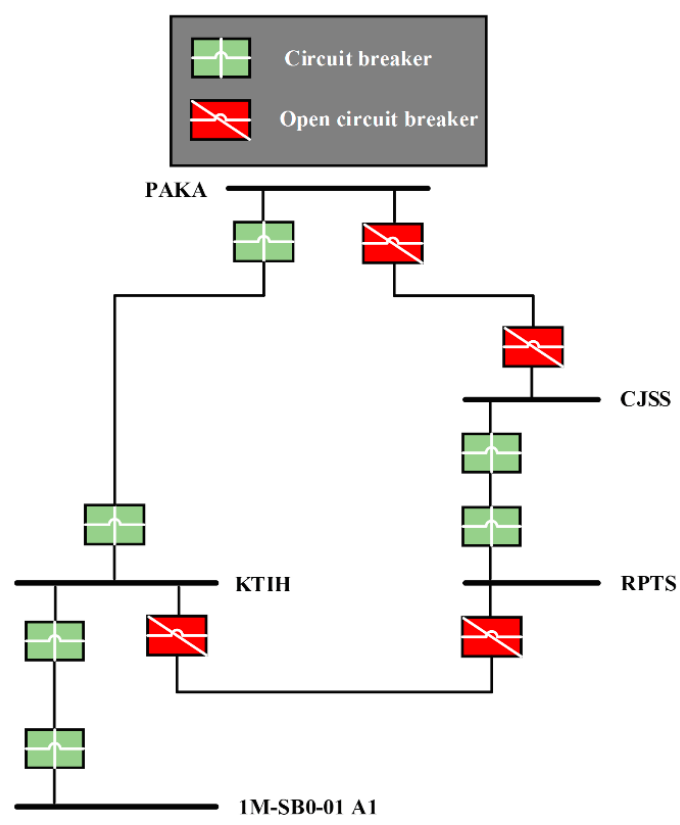
Figure 6. Islanding Scenario 4 of the test